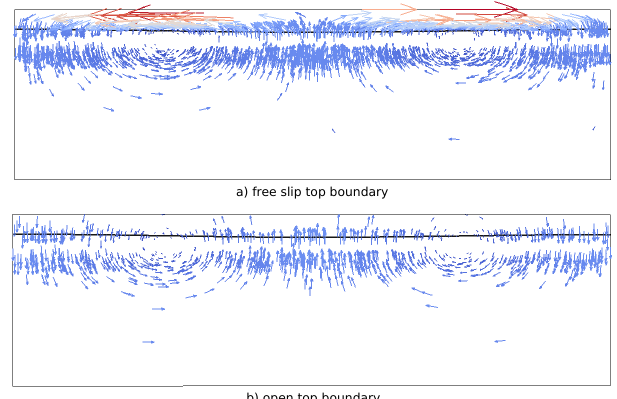
Figure 5. Flow field in a model with a free slip top boundary (a) and with an open top boundary (b) . The arrows are scaled in the same way, both in length and color. The black line denotes the zero level set and thus the surface